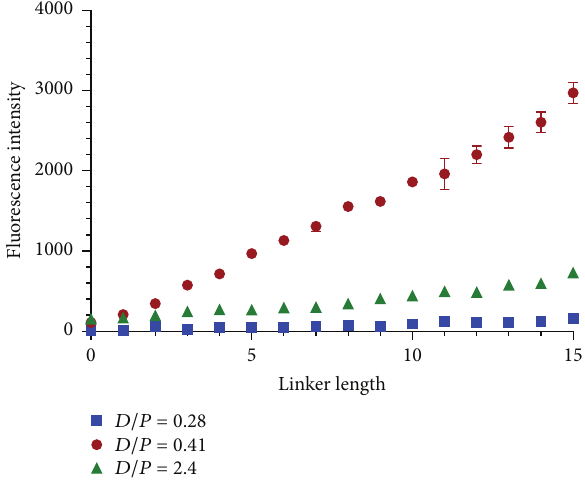
Figure 5: Signal-to-noise (S/N) comparison using direct and indi- rect dye labeling under different conditions for T 10 IgE 17-4. Biotin- IgE and Cy3-IgE concentrations were 10nM.